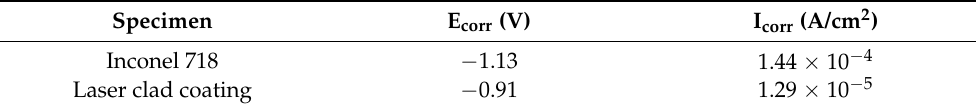
Figure 5. Potentiodynamic polarization curve of laser clad La 2 Zr 2 O 7 /NiCoCrAlY coating and Inconel 718 substrate in 3.5 wt.% NaCl aqueous solution. Table 4. Corrosion parameters of different samples in 3.5 wt.% NaCl solution.